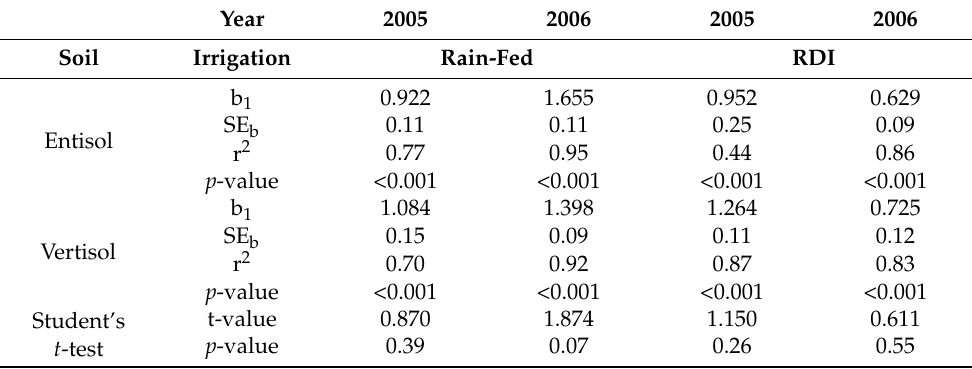
Table 2. Parameters from linear regression analysis (b 1 , SE b , r 2 , p values) between PDWP and SWP for each year (Y), irrigation treatments (I) and soil (S) (entisol and vertisol). T-values and probability values refer to the comparison of slopes ( t -test) for the two soil types for each irrigation and year combination.